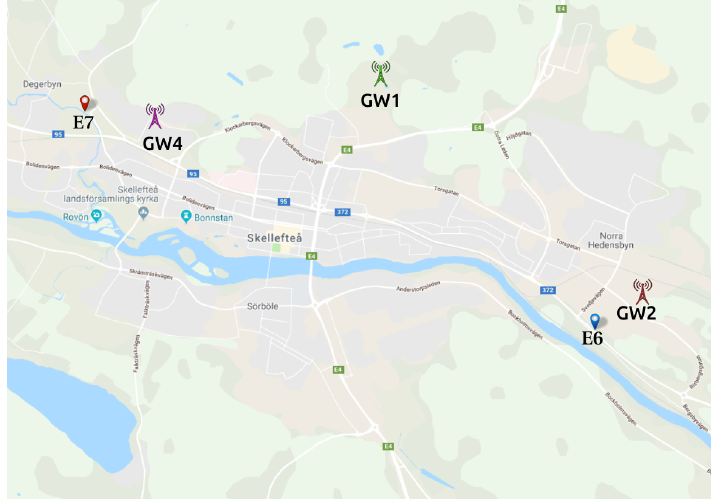
Figure 7. S3—gateways and sensors positioning. Map layer from Google Maps